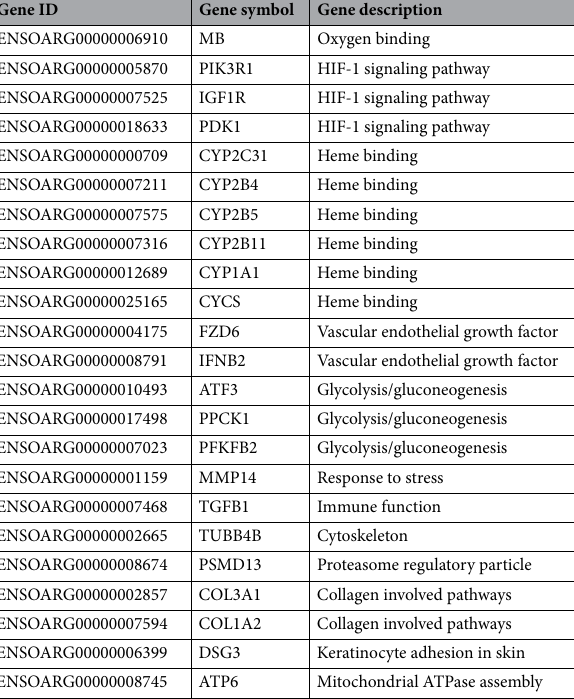
Table 2. The candidate genes putatively associated with the plateau adaptation of Tibetan